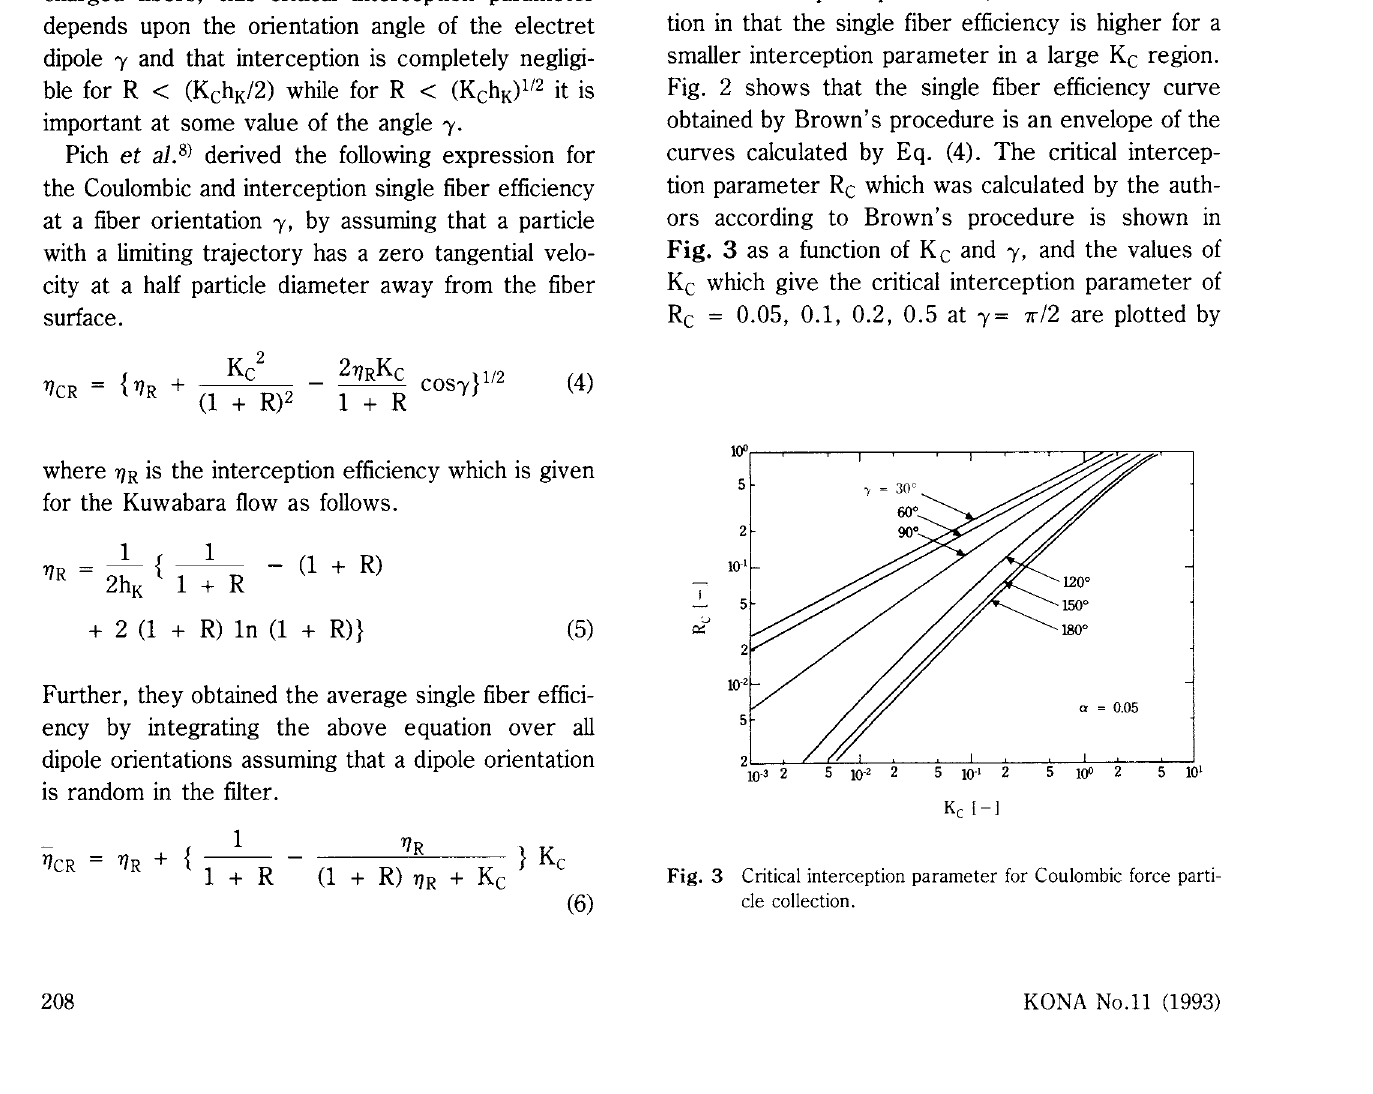
Fig. 2 Comparison of Coulombic force-interception collection efficiencies of a single electret fiber predicted by Brown and Pich et al.